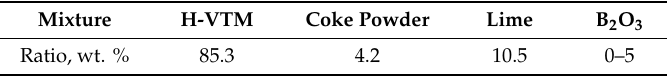
Table 1. Chemical composition of sintered raw materials (wt. %).